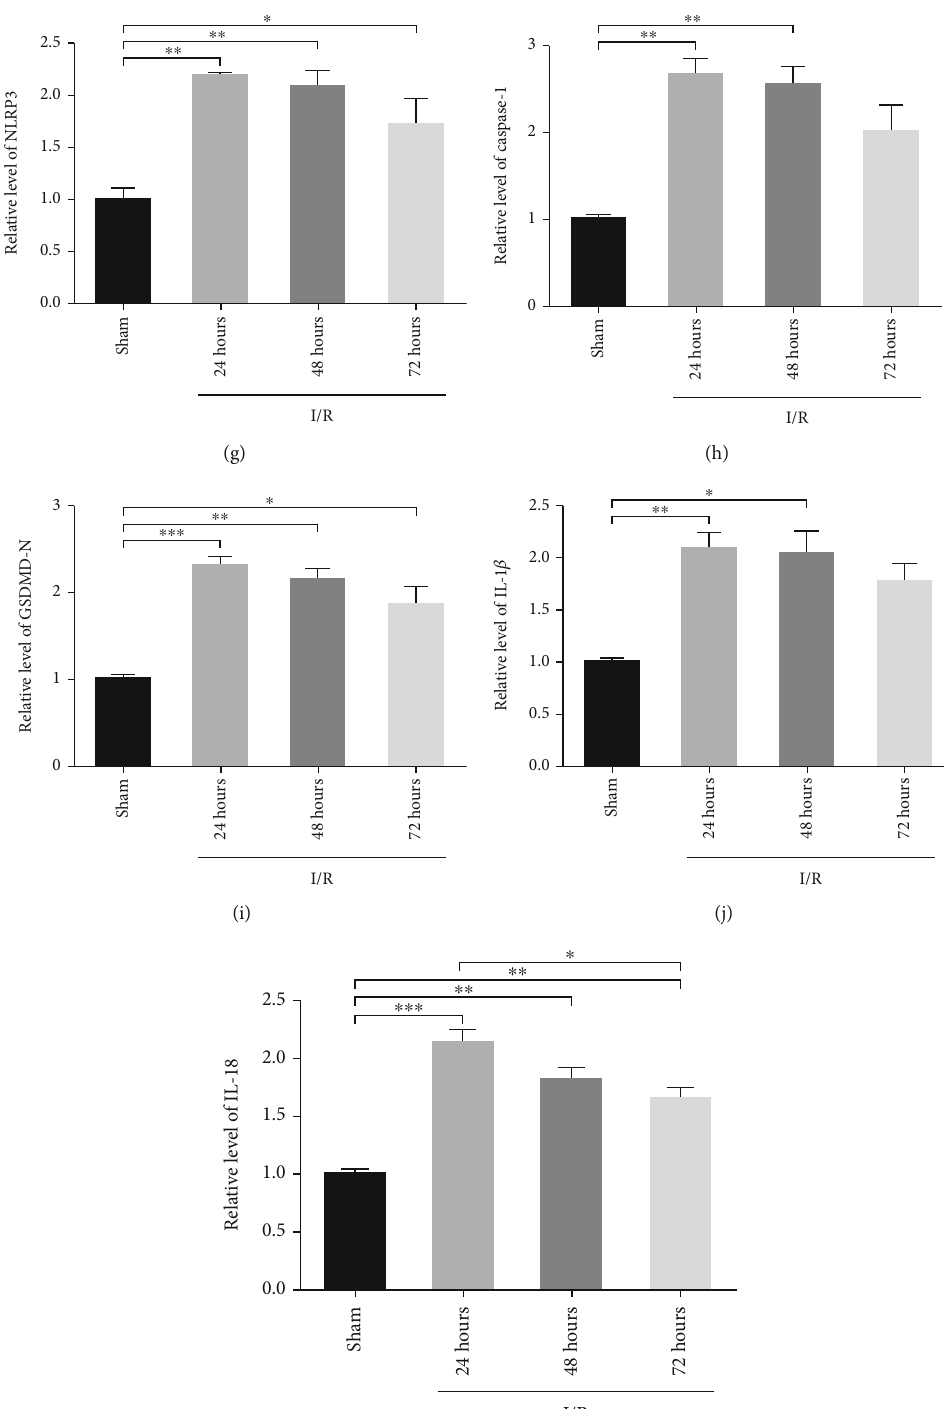
Figure 2: CI/R activated XBP-1 slicing, neuroin fl ammation, and neuron pyroptosis in the rat MCAO model. Rats were treated with MCAO. (a) The level of Xbp-1s mRNA in each group with CI/R. (b) The level of NLRP3 mRNA in each group with CI/R. (c) The level of IL-1 β mRNA in each group with CI/R. (d) The level of IL-18 mRNA in each group with CI/R. (e) Representative western blots and quanti fi cation of the indicated proteins in the hippocampal lysate from rats in each group. Relative expression was normalized to sham rats. (f – k) The expression of XBP-1s, NLRP3, Caspase-1, GSDMD-N, IL-1 β , and IL-18 in the hippocampus of the four groups after CI/R injury. Each bar represents the mean ± SEM ( n = 6 ). p > 0 : 05 , ∗ p < 0 : 05 , ∗∗ p < 0 : 01 , and ∗∗∗ p < 0 : 001 were statistically signi fi